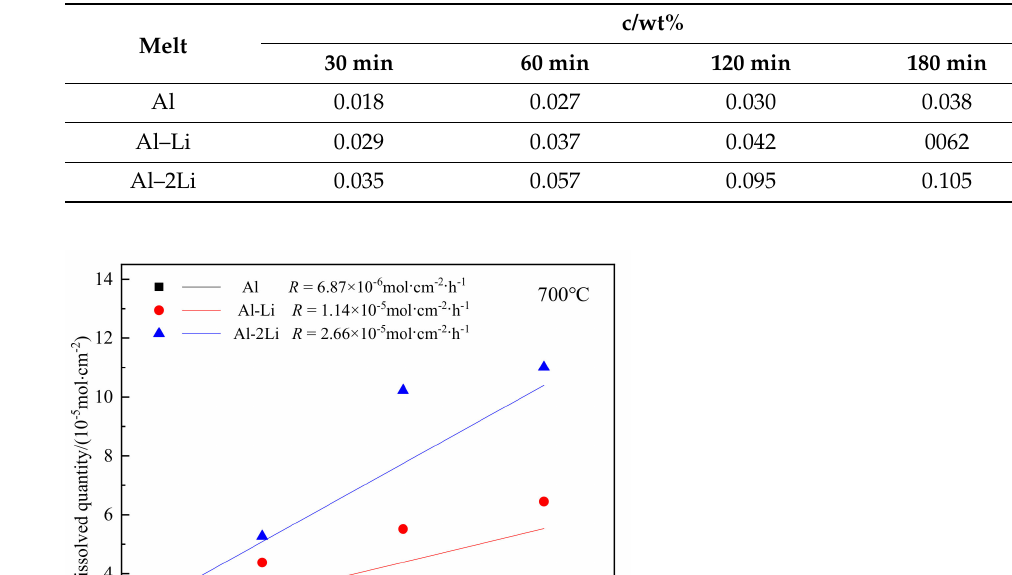
Table 4. Dependence of concentration of Ti in the melt on holding time.